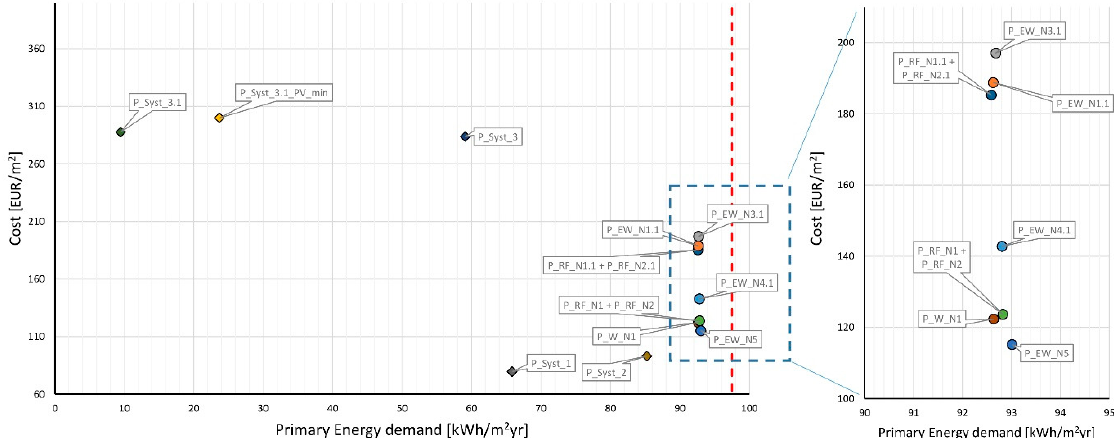
Figure 12. Cost-optimality method results for the financial scenario for the single redevelopment measures and discount factor equal to 4% for Poliziano school. The red line in the graph shows the primary energy consumption for existing building. On the right the enlargement of the first graph with the retrofitting measures for the external envelope is shown.